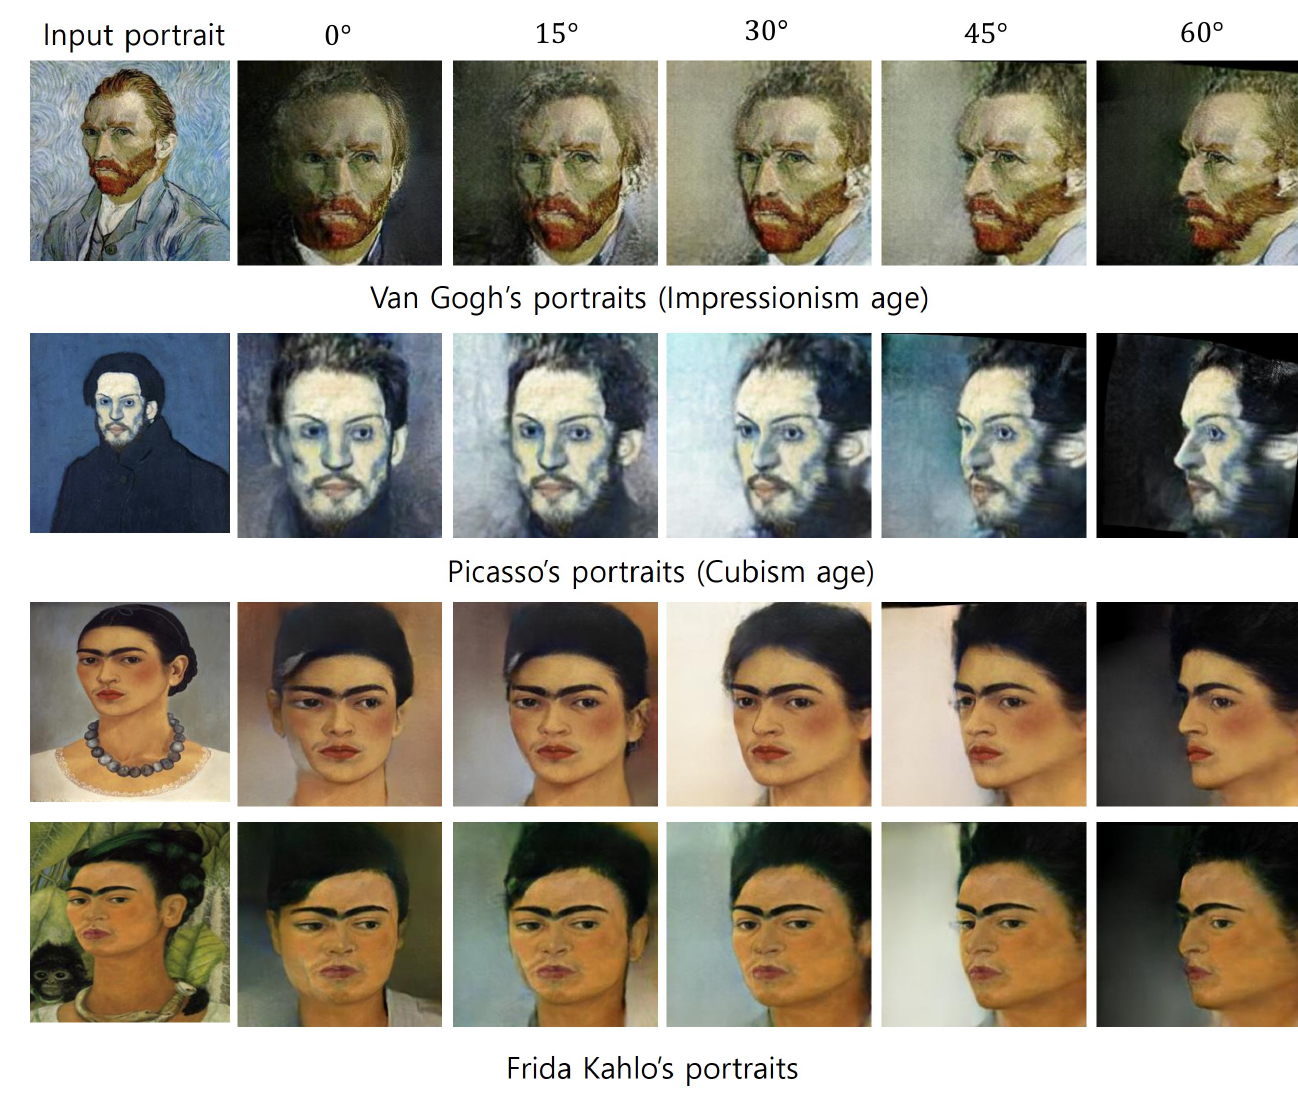
Figure 9. Left-headed artistic portraits which are rotated to the